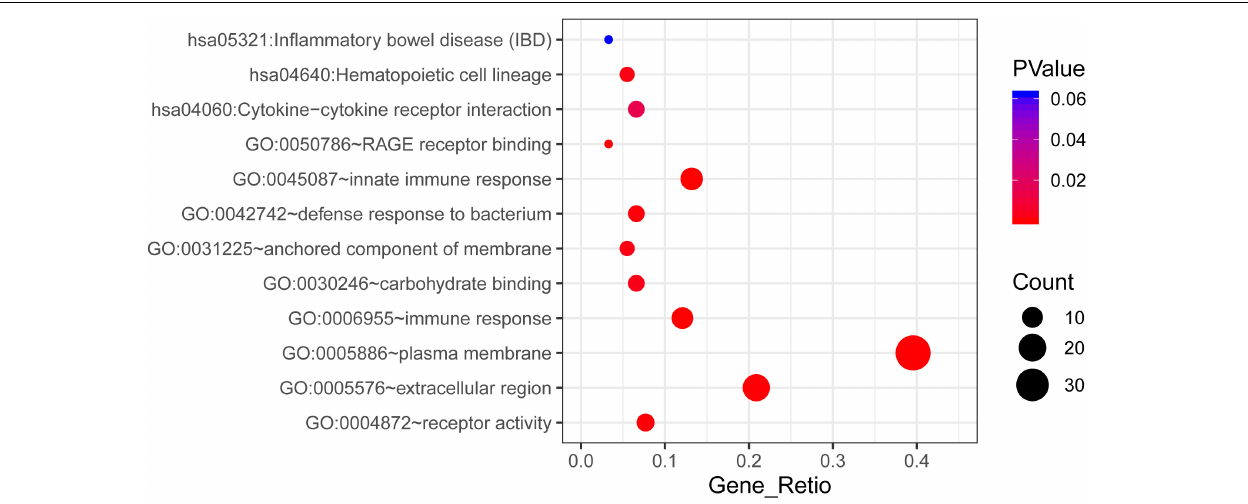
CAD, and 93 patients with old myocardial infarctions.